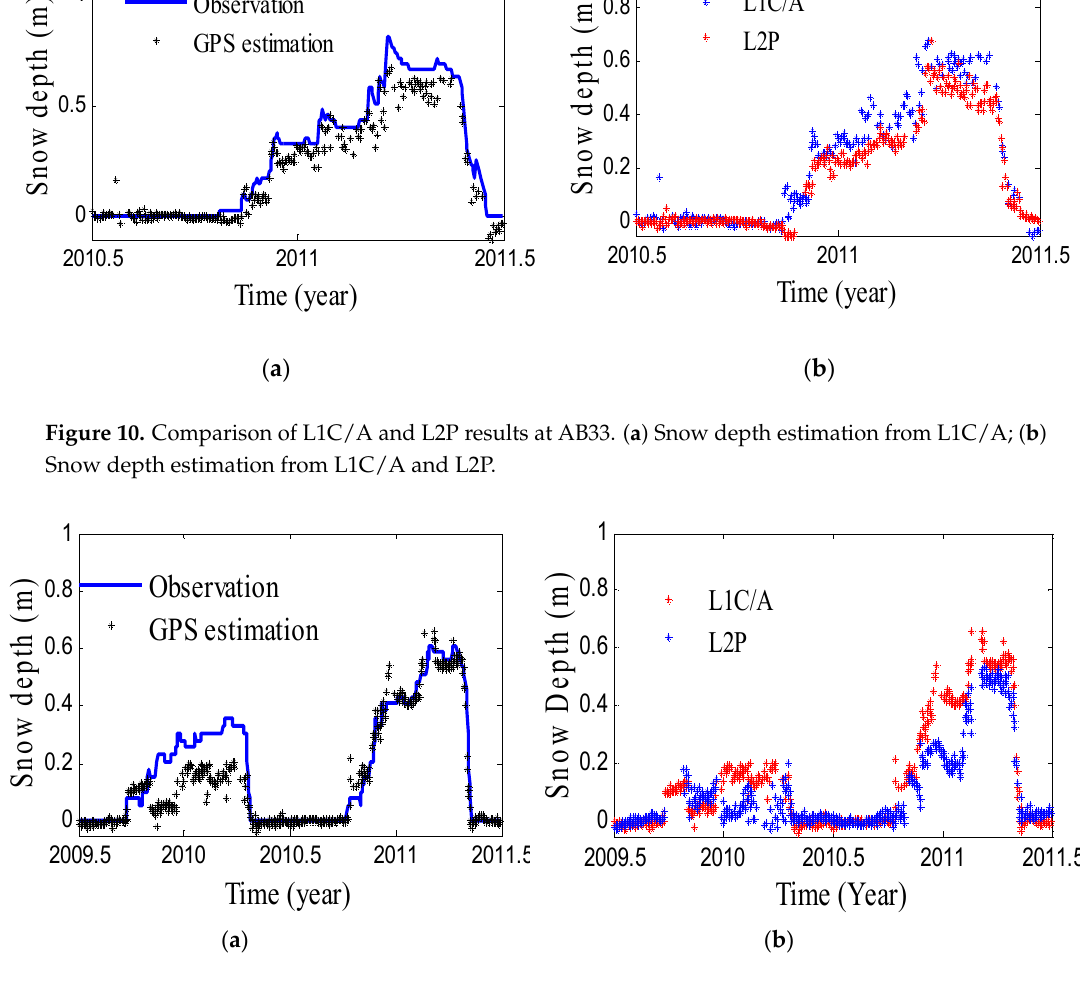
Figure 11. Comparison of L1C/A and L2P results at AB39. ( a ) Snow depth estimation from L1C/A; ( b ) Snow depth estimation from L1C/A and L2P.